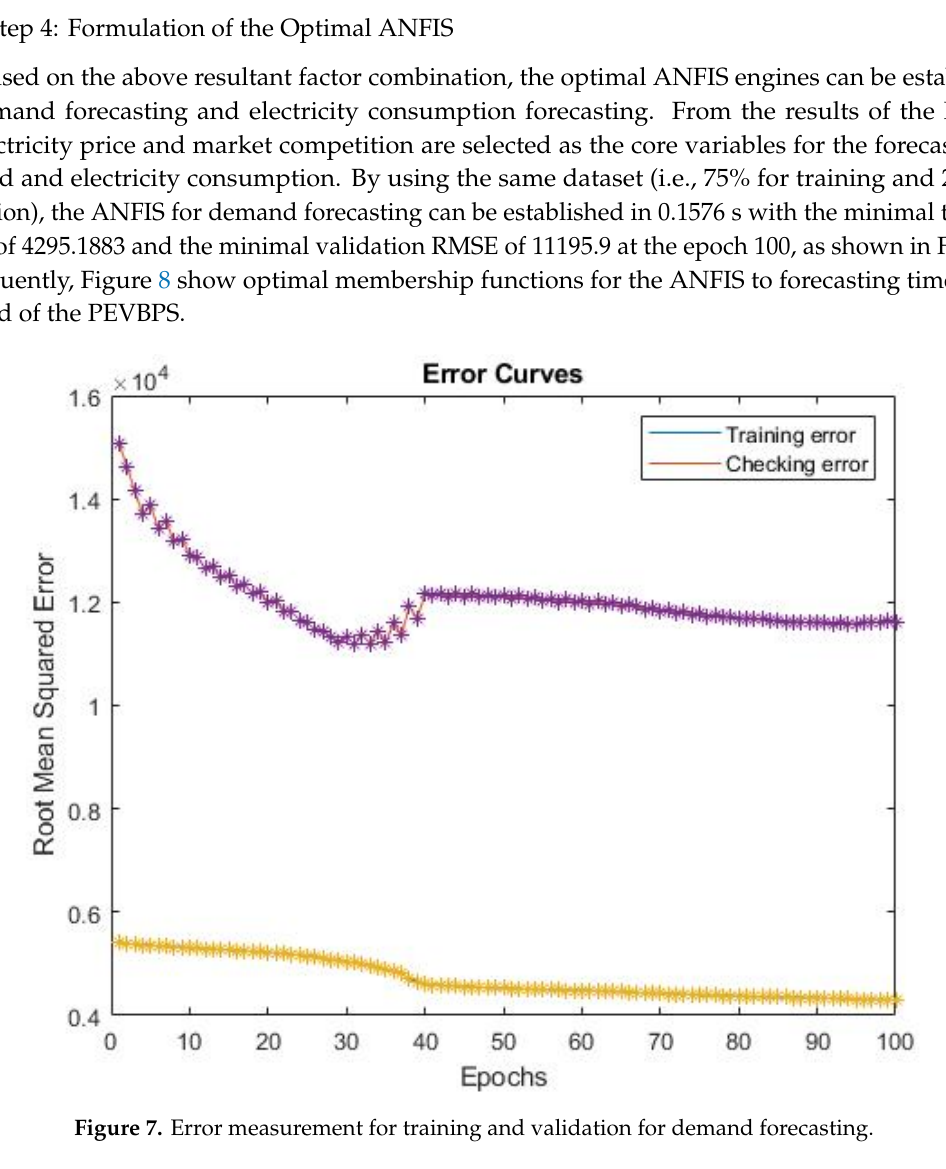
Figure 8. Optimal membership functions of the ANFIS for demand forecasting.